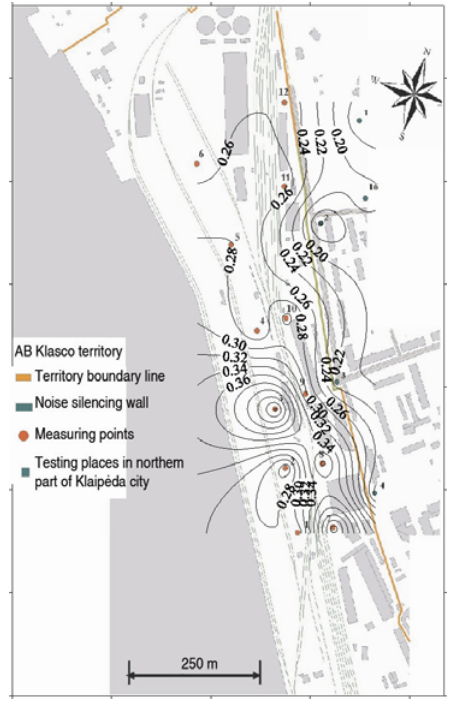
Fig 4 . Dustiness in the evening in August Comparing dust concentrations in zones I and II, we observe that in the daytime in zone I concentrations exceeded the ones in the evening 1,47 time, and in zone II concentrations in the daytime were 1,59 time higher than in the evening. In zone I concentrations in the daytime were 1,20 time less than in zone II. In the evening, in zone I concentrations were 1,11 time lower than in zone II.